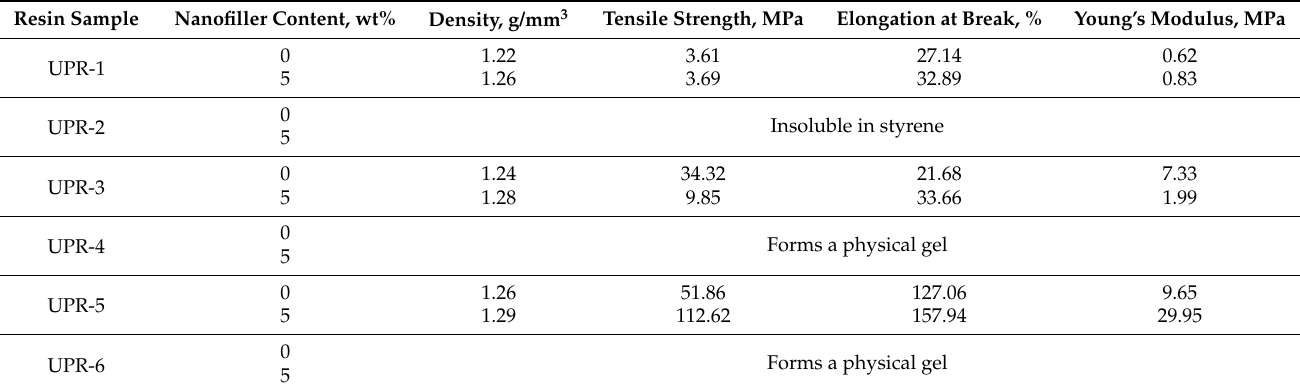
Table 6. Density and mechanical properties of UPR